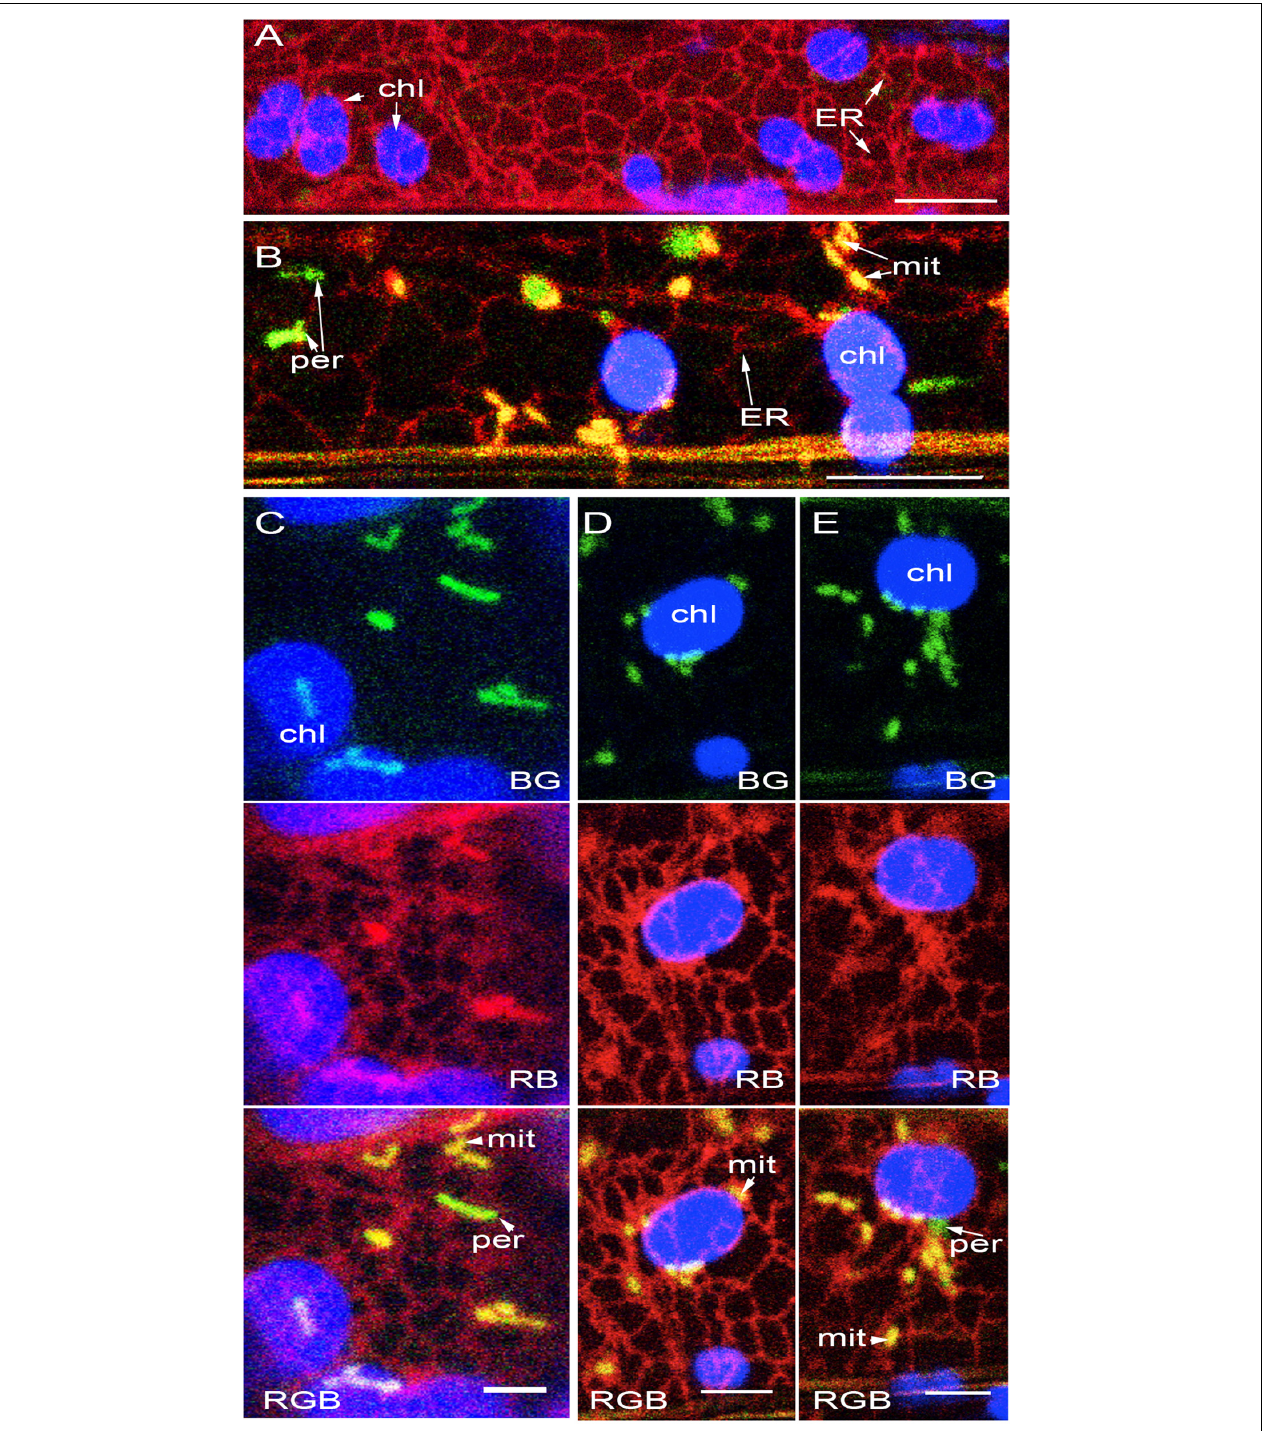
FIGURE 3 | Plastids, mitochondria and peroxisomes are individually surrounded by the ER. (A) Representative image showing the general ER mesh(red) and the loose ER-cage formed around chloroplasts (chl). (B) A representative image from GPeroxi-YMito-RER plants showing chloroplasts (chl in blue), mitochondria (mit in yellow) and peroxisomes (per in green) individually enmeshed in the ER (red). (C) Representative snapshot showing the independent spatial relationship that the ER (red) maintains with chloroplasts (chl-blue), mitochondria (mit- yellow) and peroxisomes (per -green). (D) Mitochondrial clusters in the peri-chloroplastidic ER and neighboring regions with each mitochondrion encased in its own ER. (E) Mitochondrial (mito – yellow) and peroxisomal (per- green) clusters in the peri-chloroplastidic ER (red)and neighboring regions with each of the smaller organelles encased in its own ER pocket (Based on Supplementary Movie 6 ). Scale bars- A, B = 10; C, D, E = 5 µ